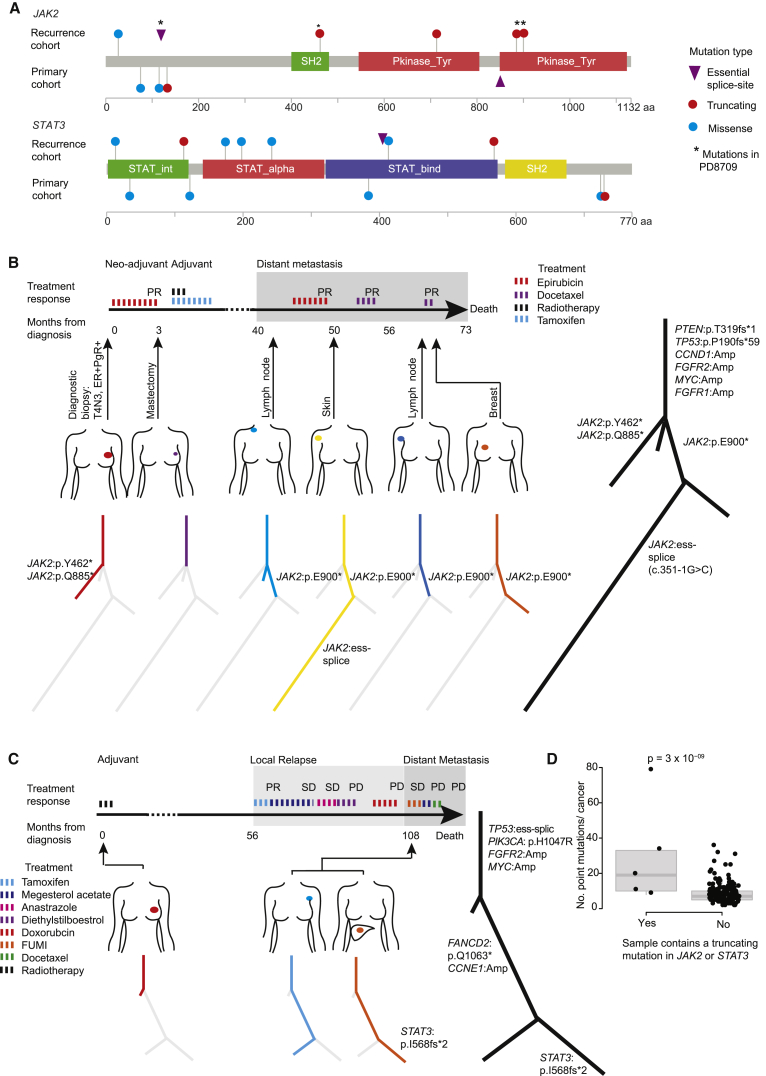
JAK-STAT Inactivating Mutations Are Enriched at Relapse(A) Pencil plots of JAK2 and STAT3 genes annotated with non-synonymous mutations identified in the relapse cohort (n = 163) and the primary cohort (n = 705).(B) A case (PD8709) of parallel evolution involving four truncating mutations in JAK2. Response to treatment exposures are documented. SD, stable disease; PR, partial response; PD, progressive disease.(C) A case (PD8727) of STAT3 truncating mutation arising in a liver metastasis.(D) Scatter and boxplot of the number of mutations identified in samples (within the relapse cohort, 163 cases) that do or do not contain a JAK2 or STAT3 truncating mutation. The box represents the interquartile range (IQR) bisected by the median, whiskers represent the maximum and minimum range of the data that do not exceed 1.5× the IQR. p value generated using an F test.